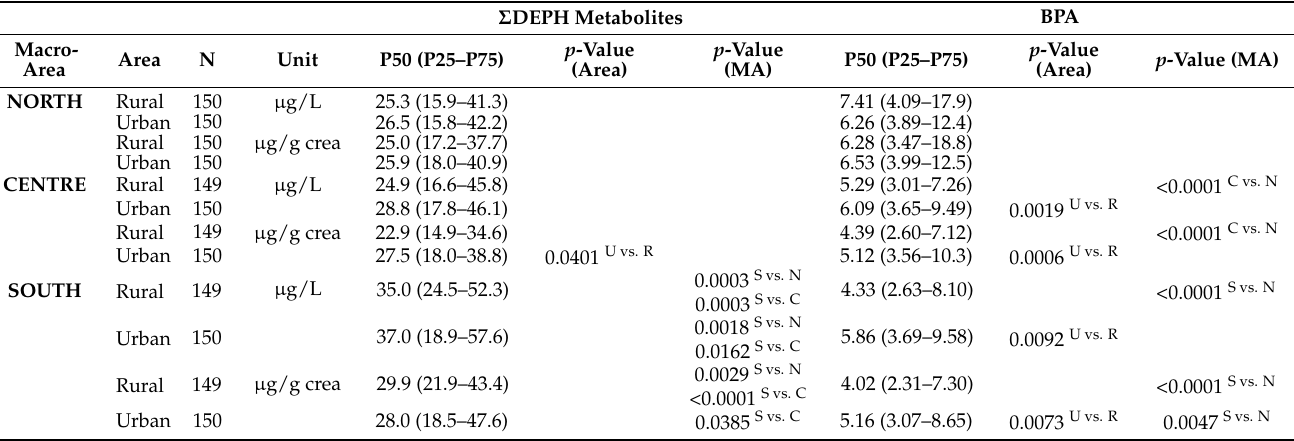
Table 4. Levels of the sum of DEHP metabolites and BPA in urine samples of women residing in rural or urban Italian areas in each macro-area. In the table are reported the median (P50) with the interquar- tile range (P25–P75) for both unadjusted (ng/mL) and creatinine-adjusted concentrations ( µ g/g). Σ DEPH Metabolites